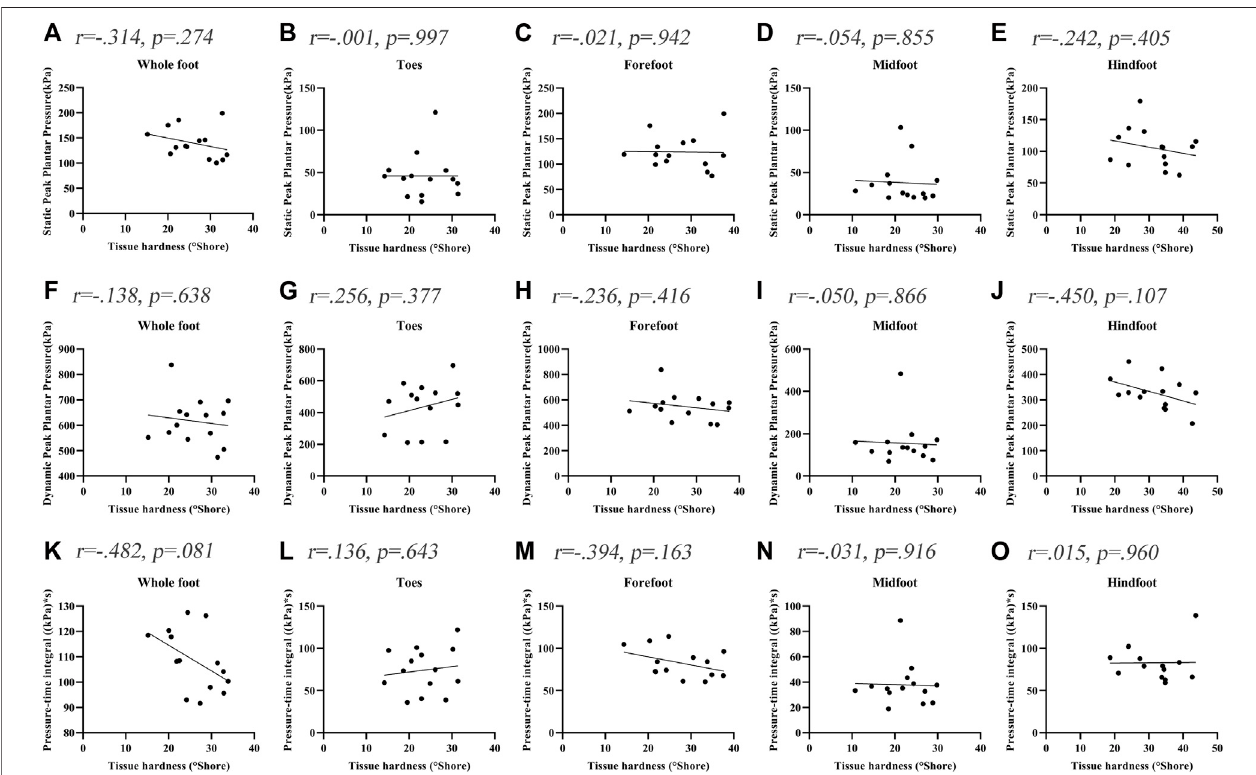
FIGURE 3 | Correlation coef fi cients between plantar tissue hardness and plantar pressure in people without DPN. (A-E) represent the correlation coef fi cients between plantar tissue hardness and static peak plantar pressure in the whole foot, toes region, forefoot region, midfoot region and hindfoot region, respectively. (F-J) represent the correlation coef fi cients between plantar tissue hardness and dynamic peak plantar pressure in the whole foot, toes region, forefoot region, midfoot region and hindfoot region, respectively. (K-O) represent the correlation coef fi cients between plantar tissue hardness and pressure-time integral in the whole foot, toes region, forefoot region, midfoot region and hindfoot region,